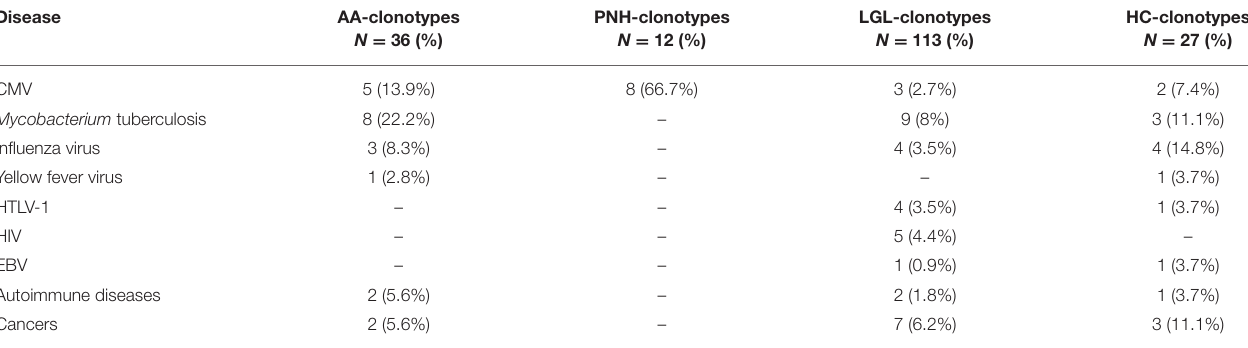
TABLE 1 | Homology assessment between BMF-related clonotypes and public database.